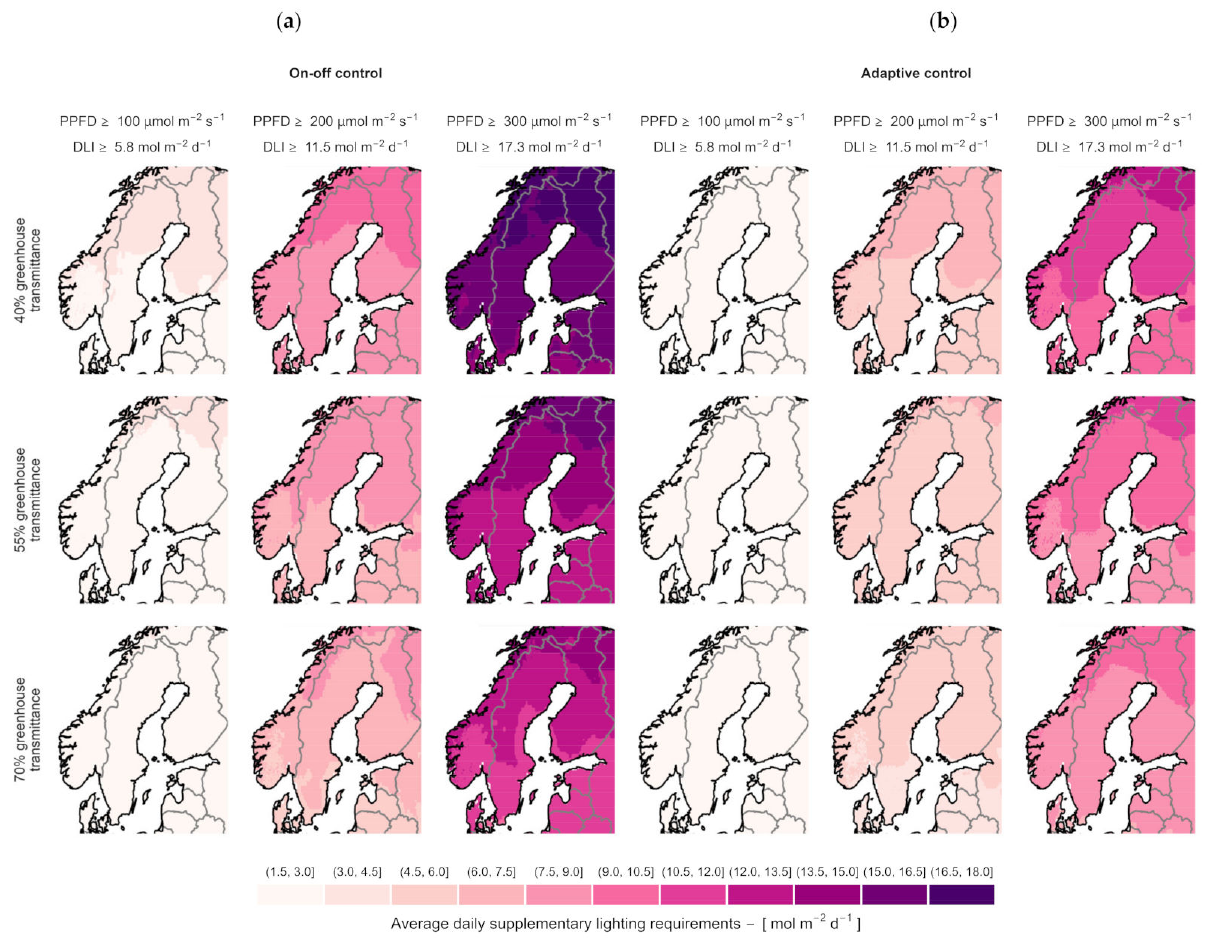
Figure 6. Average daily supplementary lighting requirements (DLI lamps , mol · m − 2 · d − 1 ) maps of the Nordic and Baltic counTable 181 days: from 1 February to 20 May and from 20 August to 31 October. A photoperiod of 16 h · d − 1 was assessed considering three minimum light settings (PPFD threshold : 100, 200 or 300 µ mol · m − 2 · s − 1 ) and three possible greenhouse hemispherical transmittances ( τ h, PAR : 40%, 55% or 70%). The two panels compare the different control protocols: ( a ) On-off control vs. ( b ) Adaptive control. Values presented as a 0.1 ◦ × 0.1 ◦ grid both in latitude and longitude, ex-tending from 54.5 ◦ N to 70 ◦ N in latitude and 4.5 ◦ E to 31.5 ◦ E in